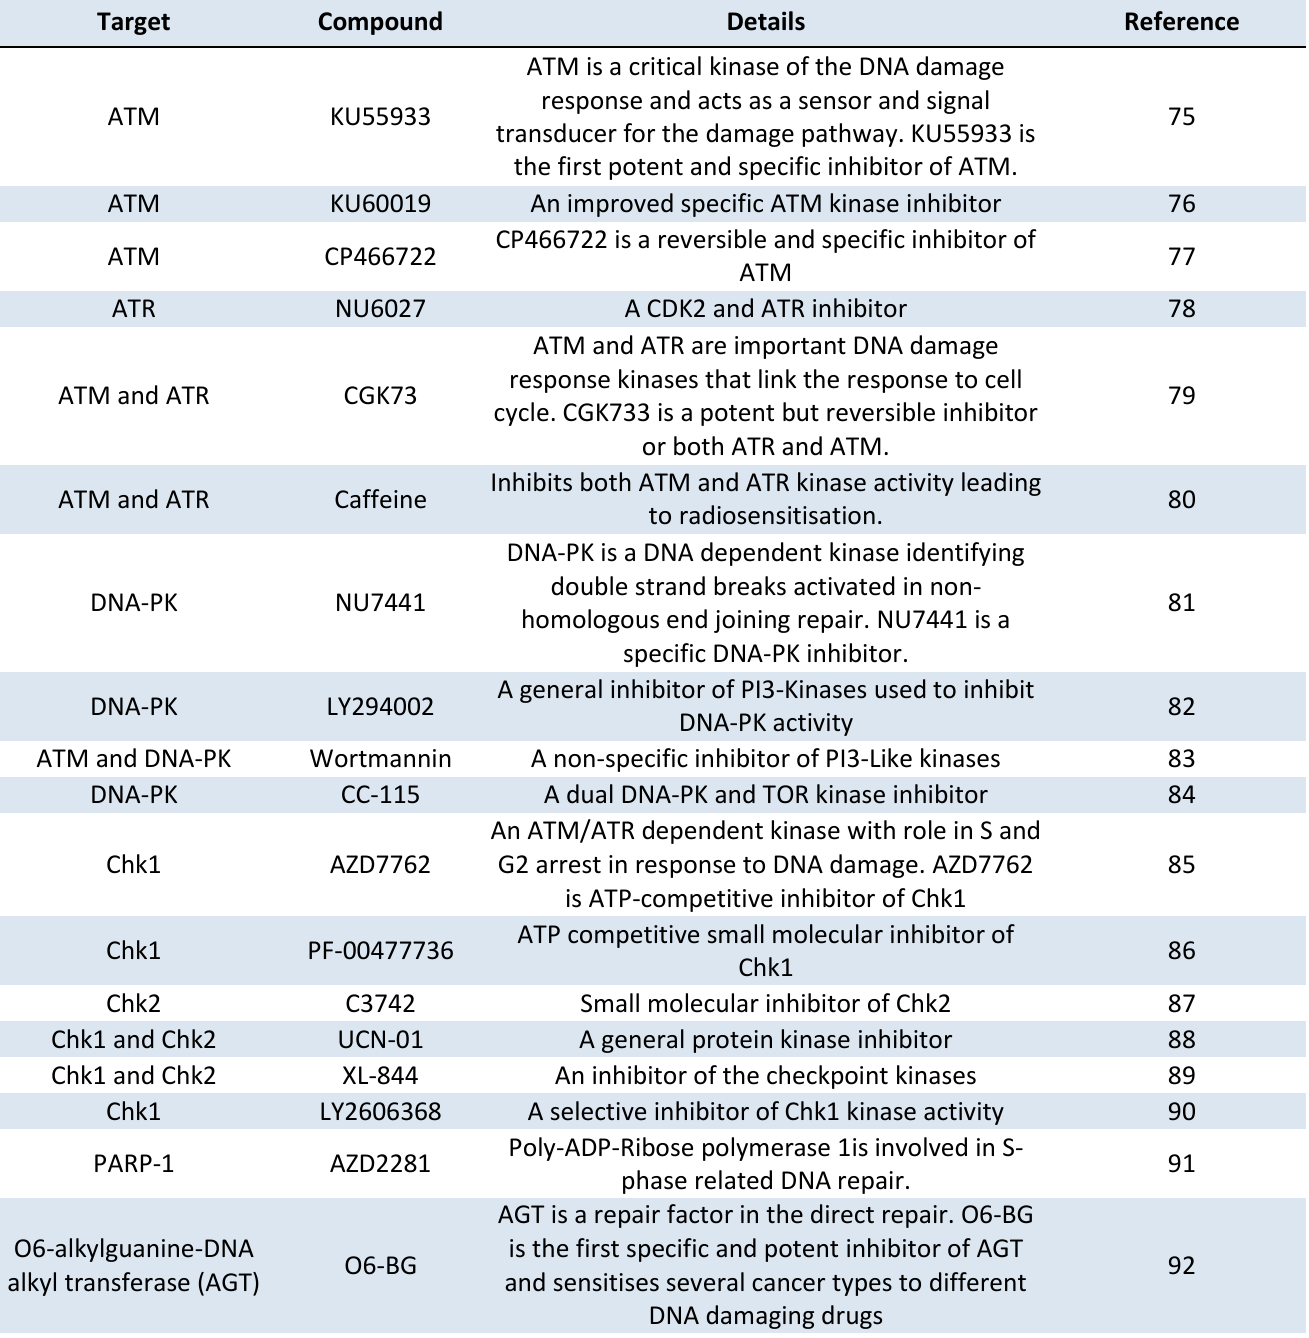
Table 3. Different inhibitors that target the major proteins involved in DNA Damage response